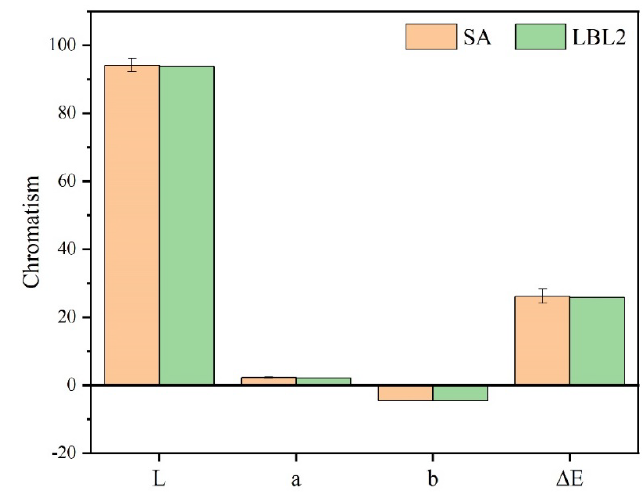
Figure 6. Chromatism of SA film and LBL2 film.